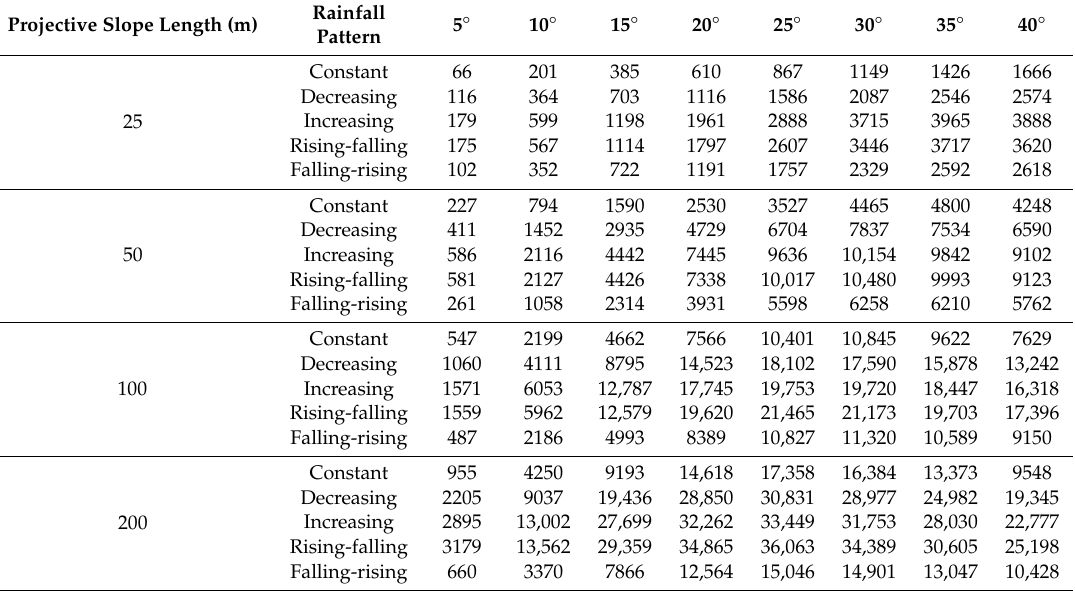
Table 3. Simulated results of total soil erosion (kg) at di ff erent projective slope